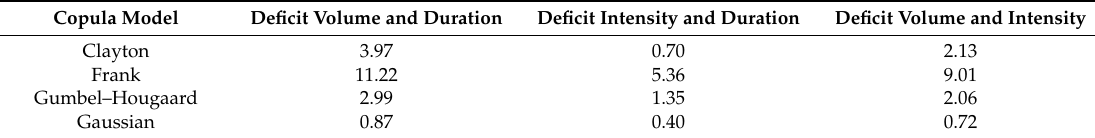
Table 4. The parameter θ estimated for each data pair with different copulas.